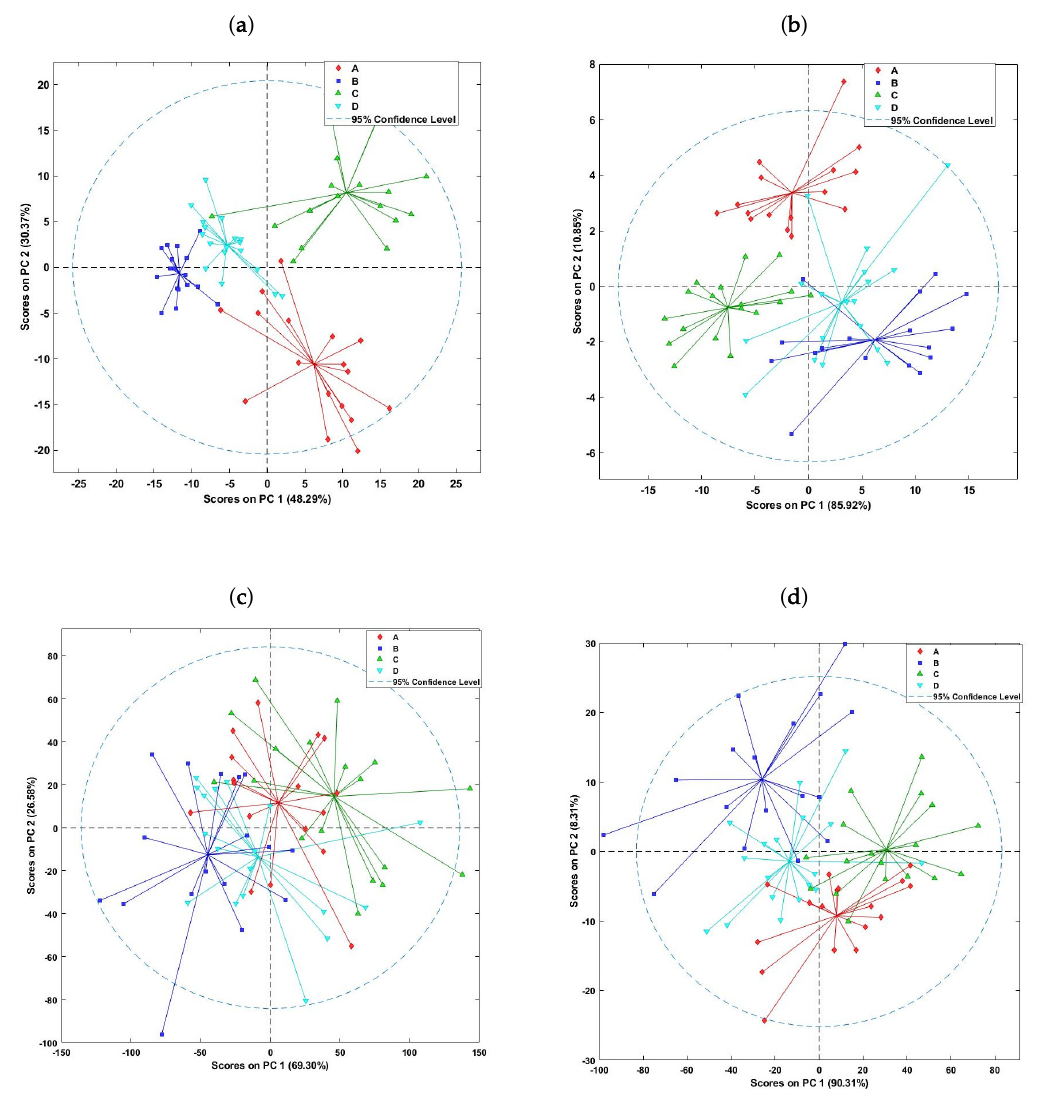
Figure 3. Principal component analysis (PCA) applied to the spectra obtained from online fluorescence ( a ) and di ff use reflectance ( b ) hyperspectral imaging, and o ffl ine full range (400–2500 nm) visible / near ( c ) and 400–1000 nm visible / near ( d ) infrared di ff use reflectance of the four lutefisk brands. Similar results were obtained with the PCA applied to the online di ff use reflectance